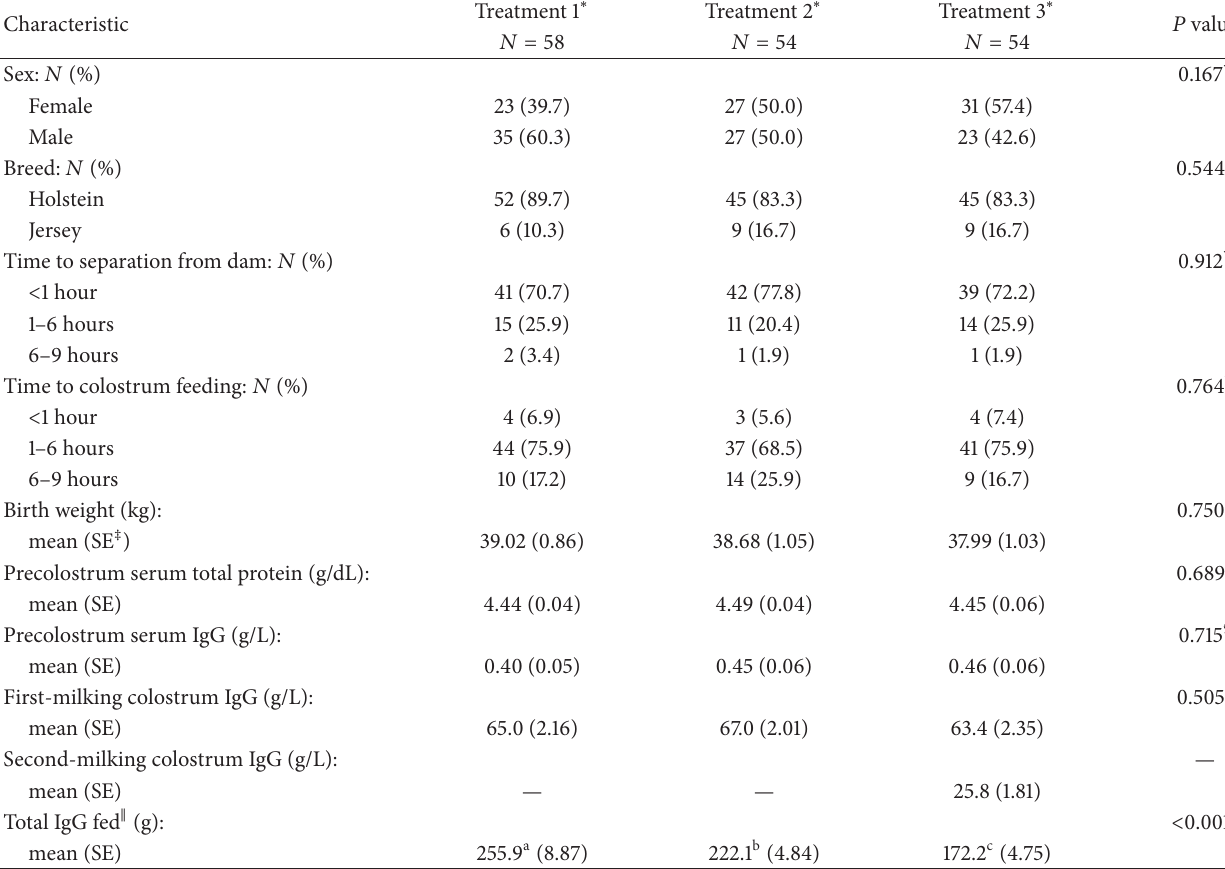
Table 1: Comparison of baseline characteristics among 3 treatments in a randomized field trial comparing the effects of feeding first- milking pooled colostrum alone or first-milking pooled colostrum followed by either a colostrum-derived replacer or second-milking pooled colostrum to newborn Holstein and Jersey